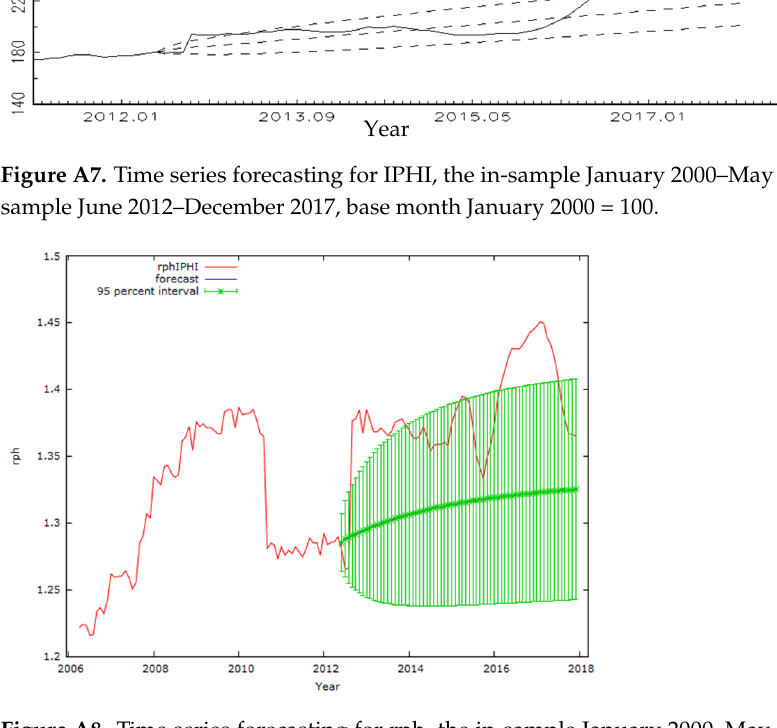
Figure A8. Time series forecasting for rph, the in-sample January 2000–May 2012, and the out-of-